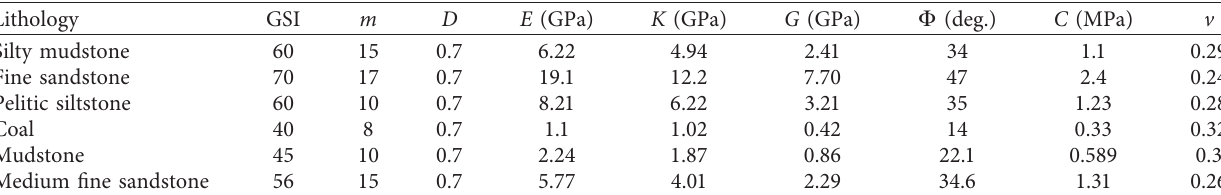
Table 4: Rock mass mechanical properties used in numerical simulation.